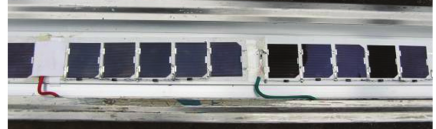
Figure 6: The photograph of the GaAs solar cell array. of the lighting plate, and solar direct radiation. In order to conveniently calculate and compare, it is supposed that the water mass flow is 0.008 kg/s, the inlet temperature of fluid is 20.0 ◦ C, solar direct radiation is 900 W/m 2 , and the ambient temperature and wind speed are 20.0 ◦ C and 1.0 m/s, respectively, in the calculation.